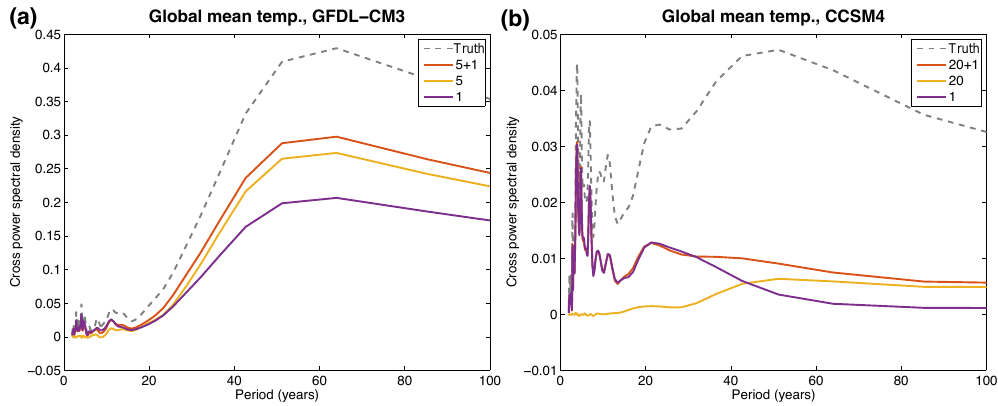
Figure 7. Cross spectra of the reconstructed global-mean temperature time series with the true global-mean temperature time series, for the reconstructions shown in Fig. 6. For reference, the dashed gray line indicates the cross spectra of the true time series with itself, or equivalently its own power